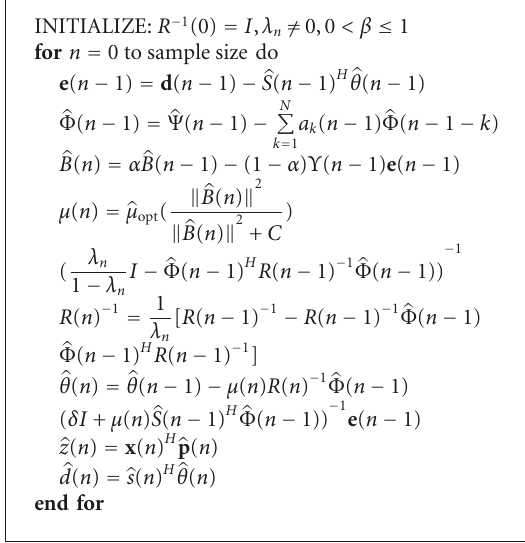
Algorithm 1: Summary of the proposed Variable Step-size Ham- merstein adaptive